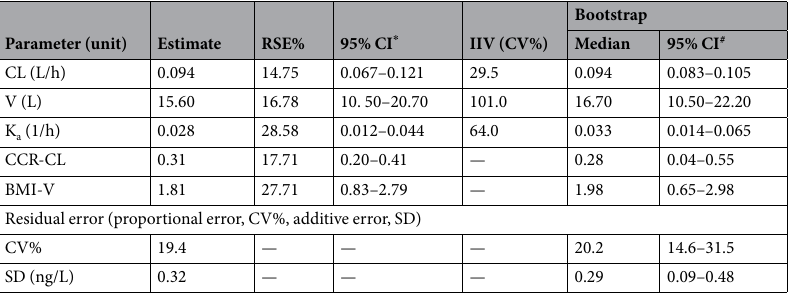
Fig. 3A’. The scatter plots of DV versus prediction (PRED) were displayed in Fig. 3B and B’, and PRED of final model agrees well with DV. The diagnostic plots of conditional weighted residuals (CWRES) versus PRED and TIME (time after dose) show that CWRES in 3C ′ and 3D ′ are closer to zero line than 3C and 3D, indicating the final model fits the observations better. Two covariates were retained in the final model. Figure 4 displays the dis- tribution of η 1 (IIV for CL) and η 2 (IIV for V) for basic ( η 1 basic and η 2 basic ) and final ( η 1 final and η 2 final ) population models. As the covariates were incorporated into the model, the variance of IIV for CL and V has become smaller. This indicates that part of IIV could be explained by the enrolled covariates. In addition, the bootstrap was also performed and the results were listed with the final estimates in Table 2. Our bootstrap analysis shows a successful rate of 94.6% (946 out of 1000 were successful in minimization). The 95% confidence interval (95% CI) of bootstrap analysis shows an acceptable robustness in the final population pharmacokinetic model. Peginterferon α 2a visual predictive check (VPC) with the 90% prediction interval (90% PI) using the final population model overlaid with the actual original observations is shown in Fig. 5. The dashed lines are 5 th and 95 th percentiles and the solid lines are predicted 50 th percentile. The area between the 5 th and 95 th